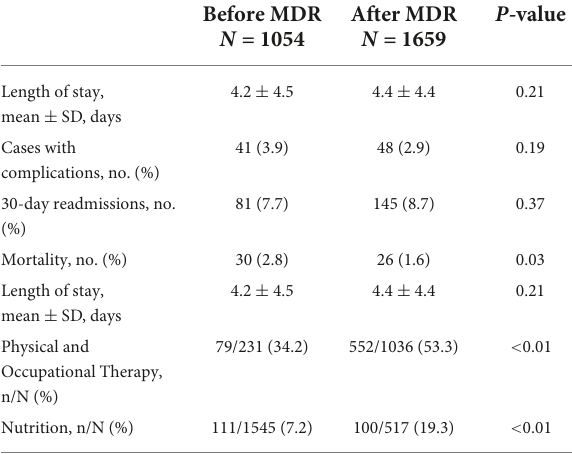
TABLE 2 Clinical outcomes before and after the implementation of MDR.